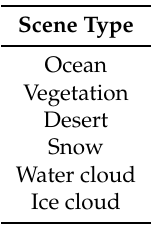
Table 3. Scene types for radiative transfer simulations.